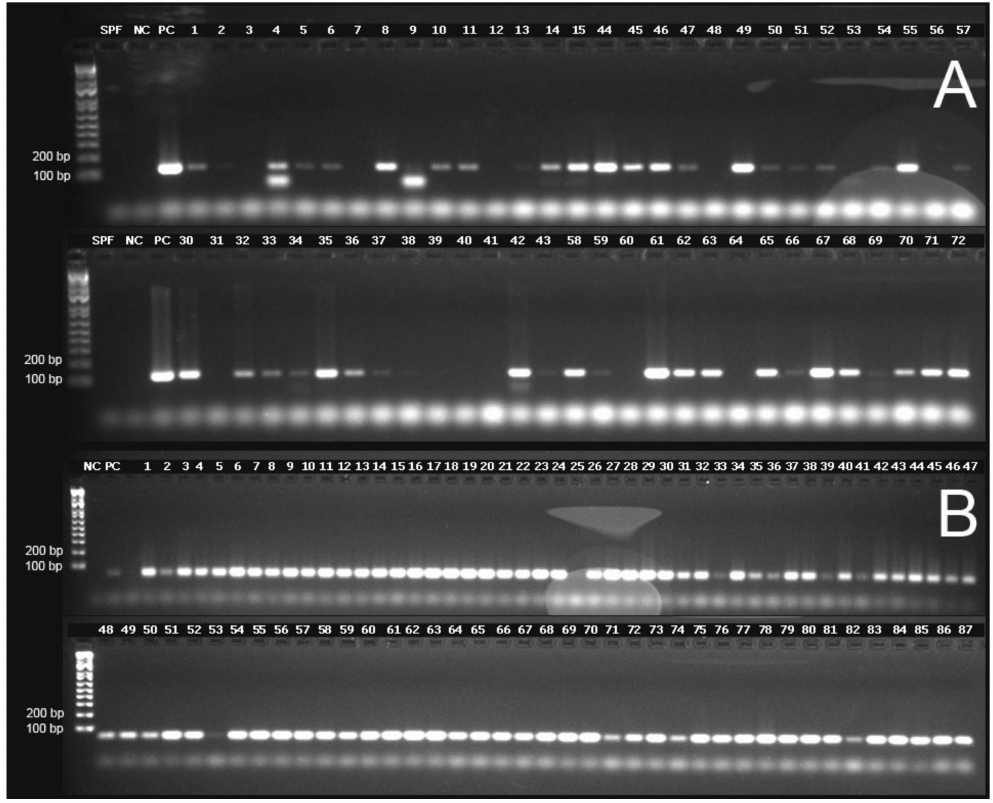
Figure 4. Representative agarose gel electrophoresis images for the detection of TSV genes and the internal control gene EF-1 α (elongation factor 1- α ). ( A ) TSV VP1 gene (primer pairs TSV-5, amplicon size 122 bp). ( B ) Shrimp EF-1 α gene. SPF = Specific Pathogen Free negative control, NC = no template control, PC = TSV positive control. The first lane in each gel represents a molecular weight marker (Invitrogen 1 kb Plus DNA